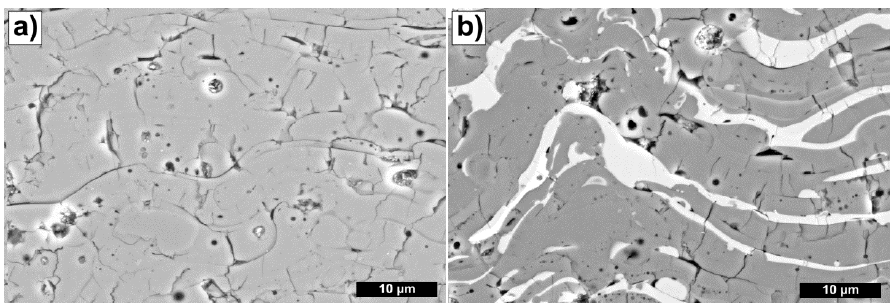
Figure 5. Microstructure of ( a ) APS_A and ( b ) APS_AT1 coatings. FE-SEM